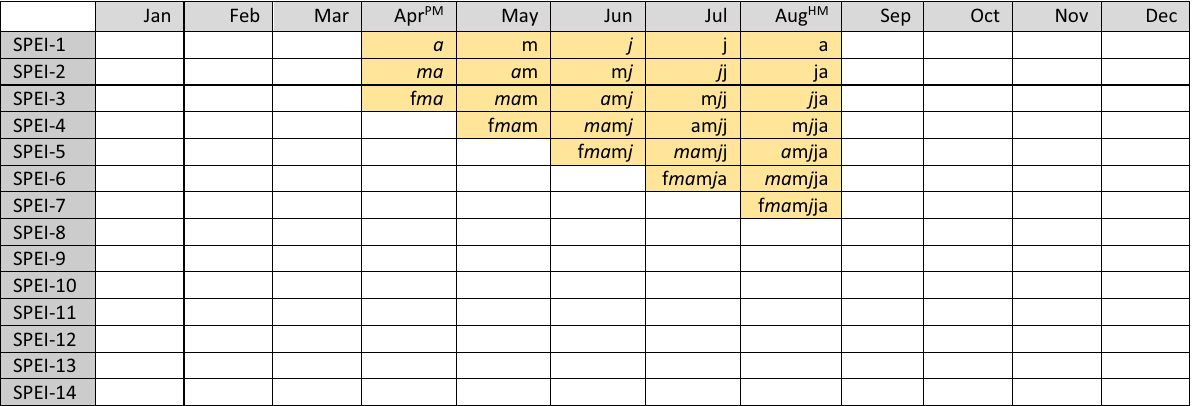
Figure 5. Example (yellow cells) of the sub-set of SPEI durations and timings considered if assuming harvest in August and a 5-month season length (i.e., planting in April). The superscripts PM and HM represent the planting and harvesting month, respectively. In each yellow cell, the small letters represent the consecutive months considered in the SPEI- d calculation and in particular: f = February, m = March, a = April, m = May, j = June, j = July, a =